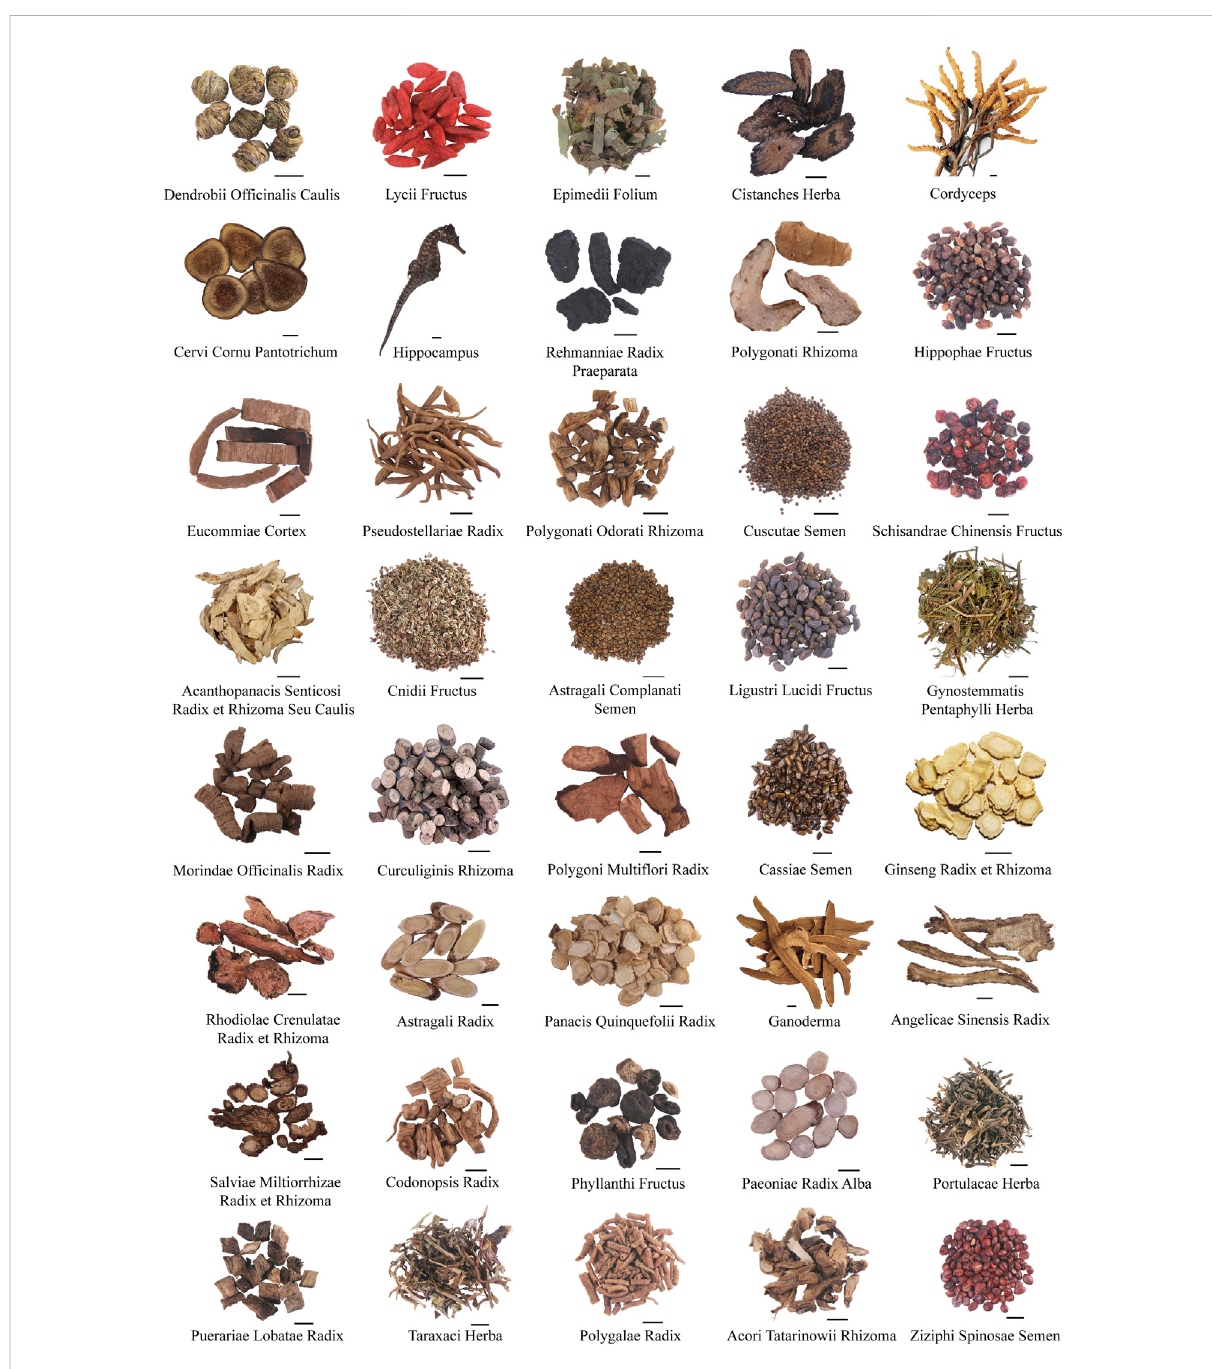
FIGURE 1 Representative TCMs with relieving effect on exercise-induced fatigue (Scale bar 1